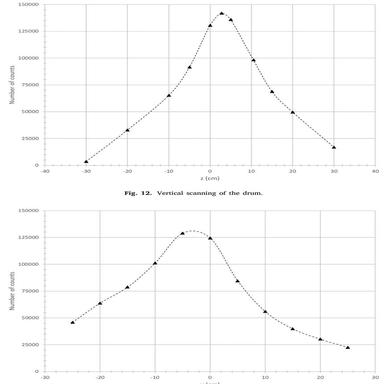
Horizontal scanning of the drum.